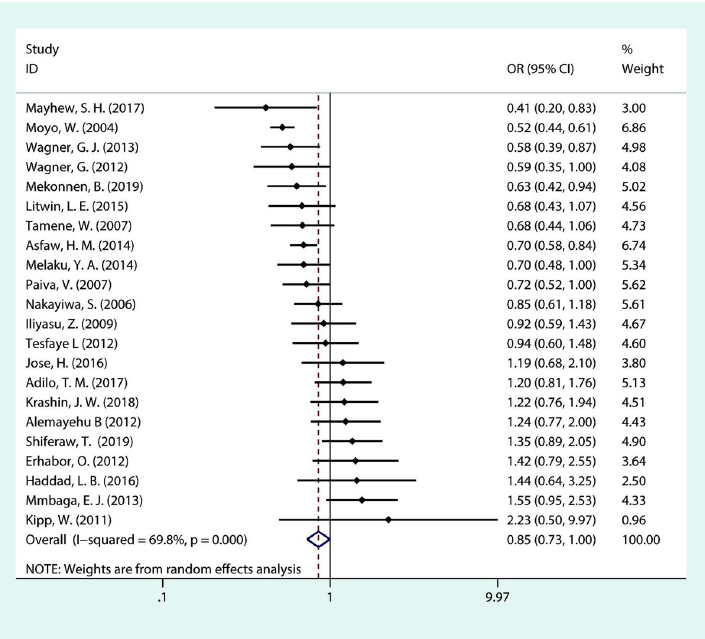
Fig 7. Forest plot of pooled OR for fertility desire in PLHIV (up to primary vs secondary or above).